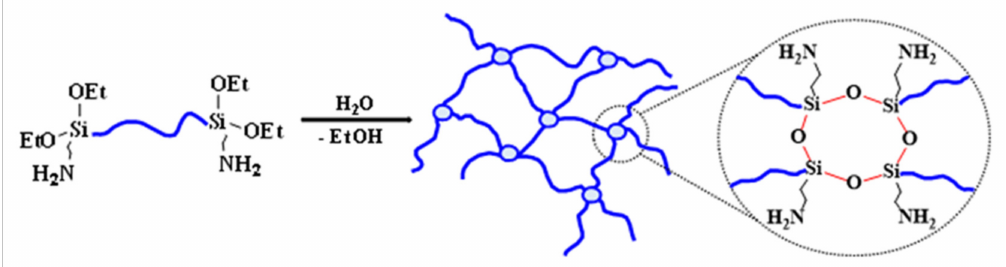
Figure 4. Curing scheme for 3-aminopropyl diethoxysilyl-terminated PDMS ( P1 or P2